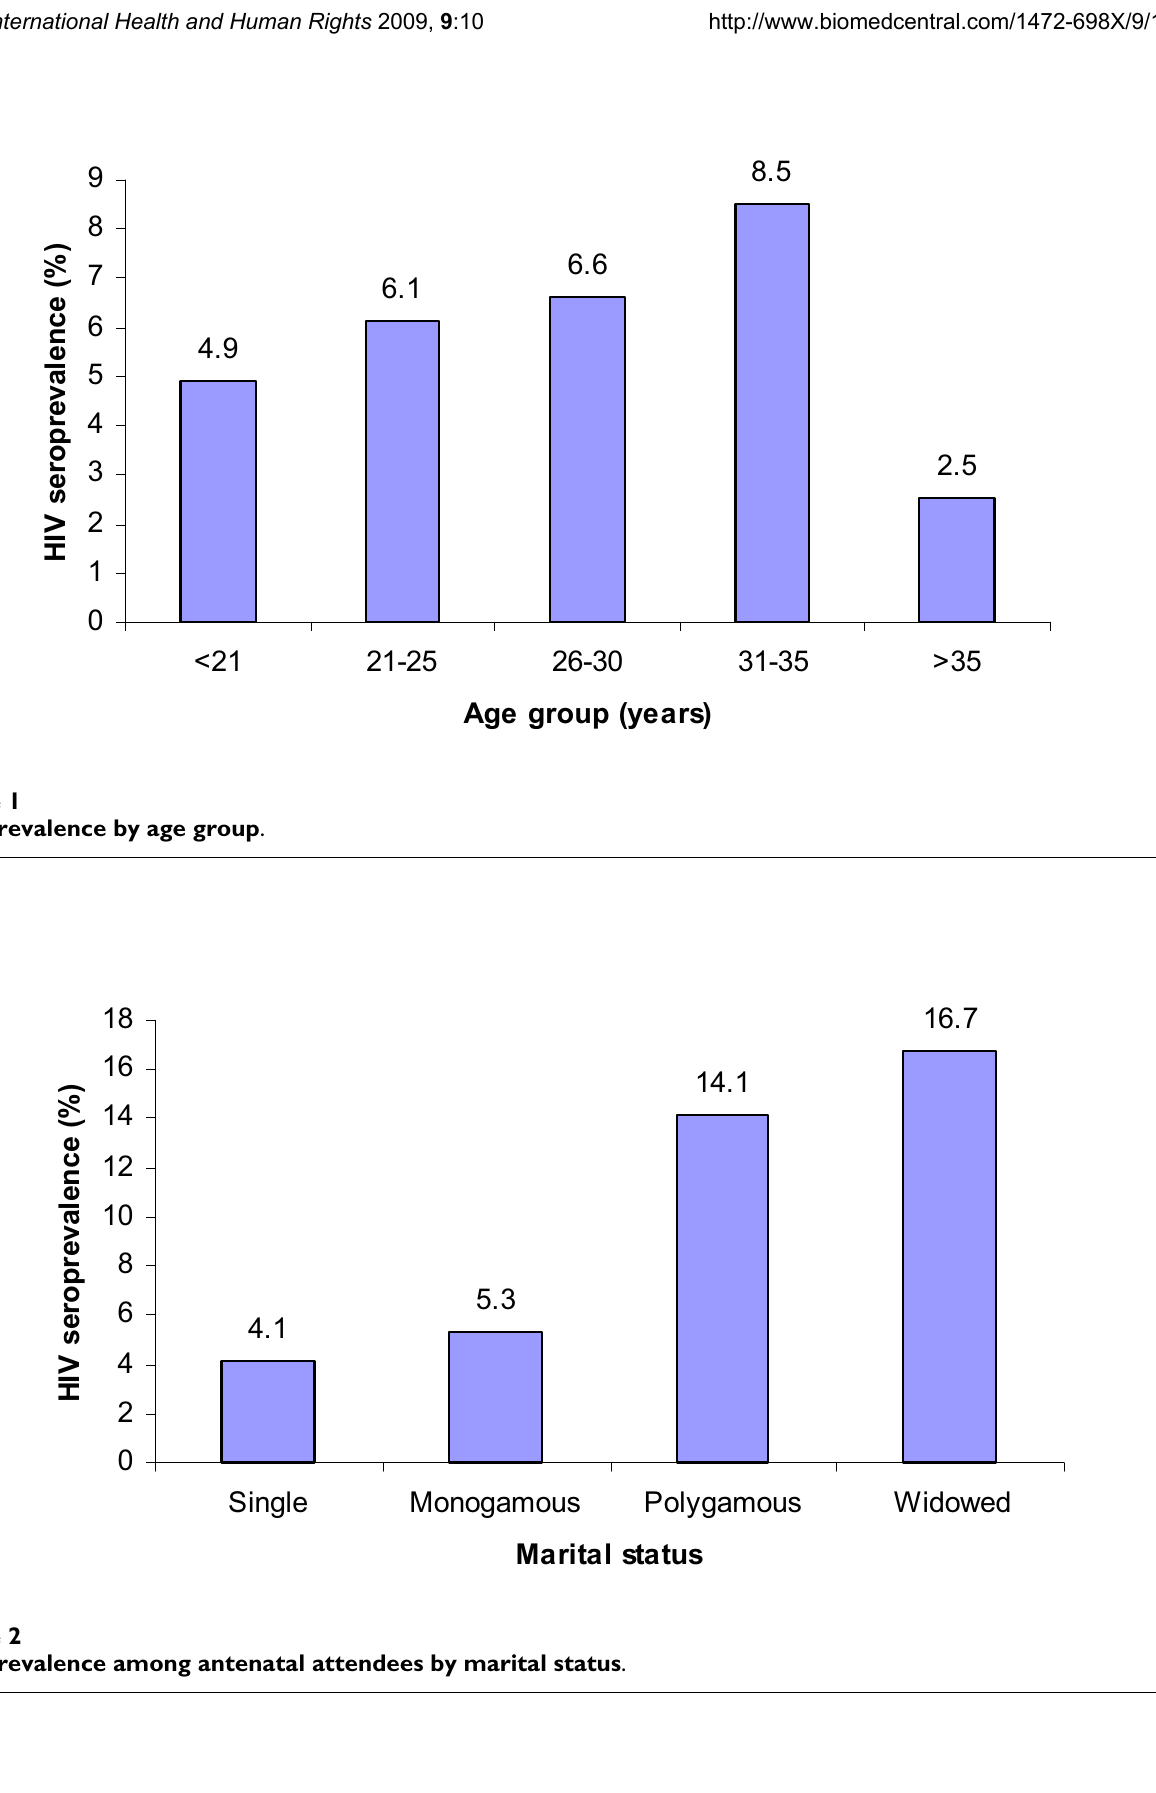
Figure 2 HIV Prevalence among antenatal attendees by marital status